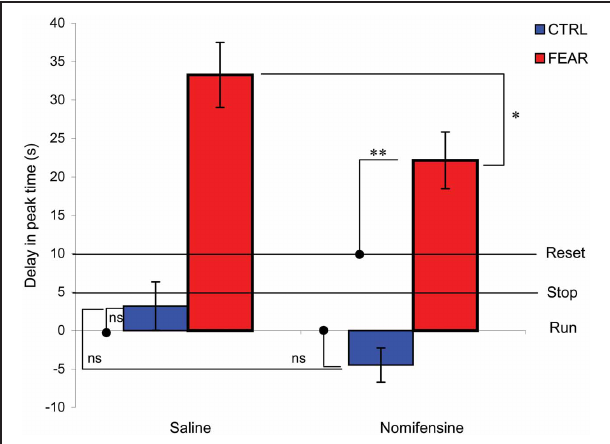
FIGURE 5 | Average delay for trials with and without noise distracter. Average peak time delay ( ± SEM) in trials with distracters (PI + N) relative to trials without distracters (PI). Should the distracter have no effect, the clock would continue to time (run, delay = 0s). Should the clock stop timing during the distracter, the delay would be equal to the duration of the noise (stop, delay = 5s). Should the clock restart timing after the distracter, the delay would be equal to the duration of the noise, 5s, plus the duration of the pre-distracter interval, 5s (reset, delay = 10s). Rats ignored a neutral distracter (CTRL). In contrast, rats over-reset when the distracter is emotionally charged (FEAR). Nomifensine reliably reduces the time delay. ∗ p < 0 . 05; ∗∗ p < 0 . 01; ns, p > 0 .